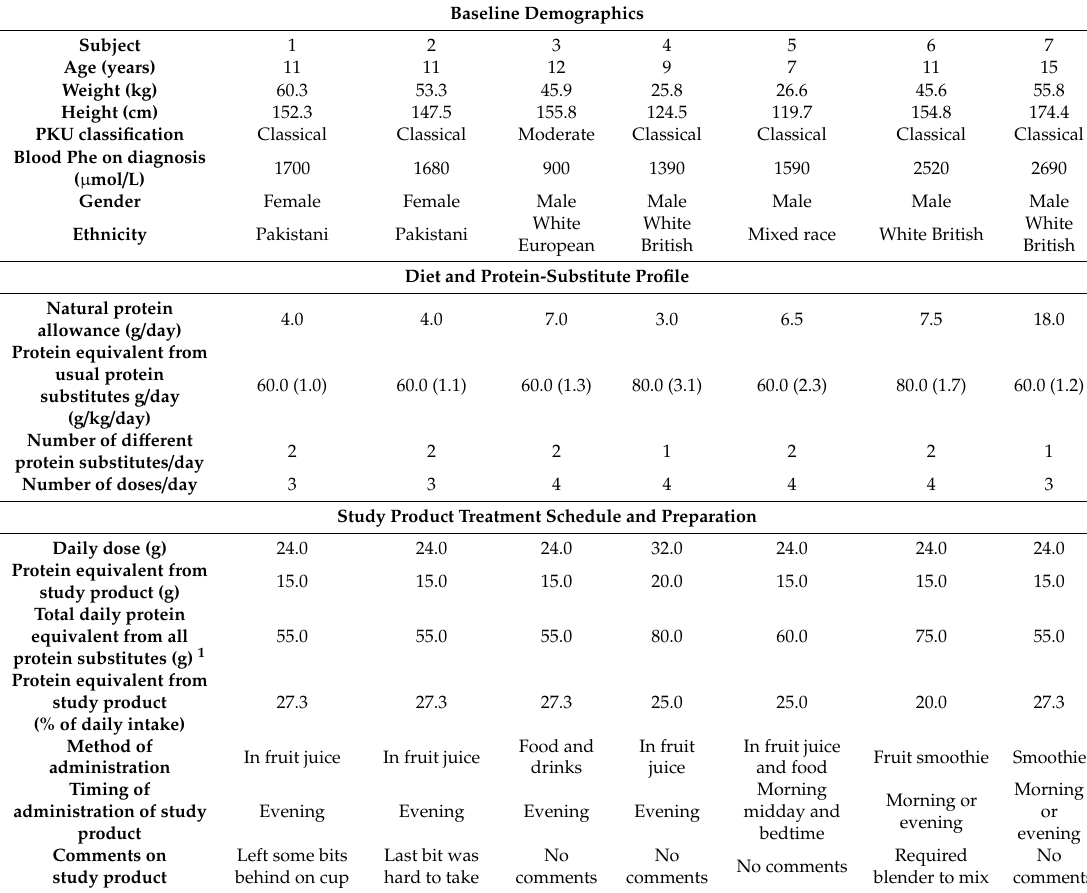
Table 2. Baseline demographics and treatment in the substudy